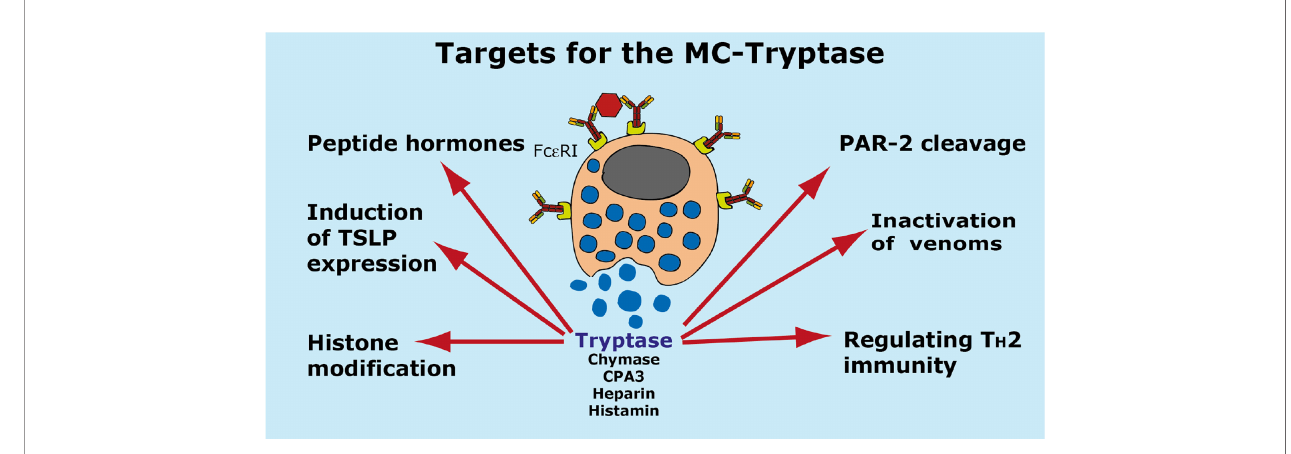
FIGURE 7 | Targets for the human MC-Tryptase. A number of potential targets for the human MC tryptase is